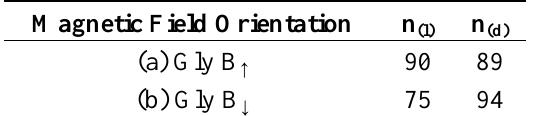
Table 6. Control experiment with an achiral additive: Gly.